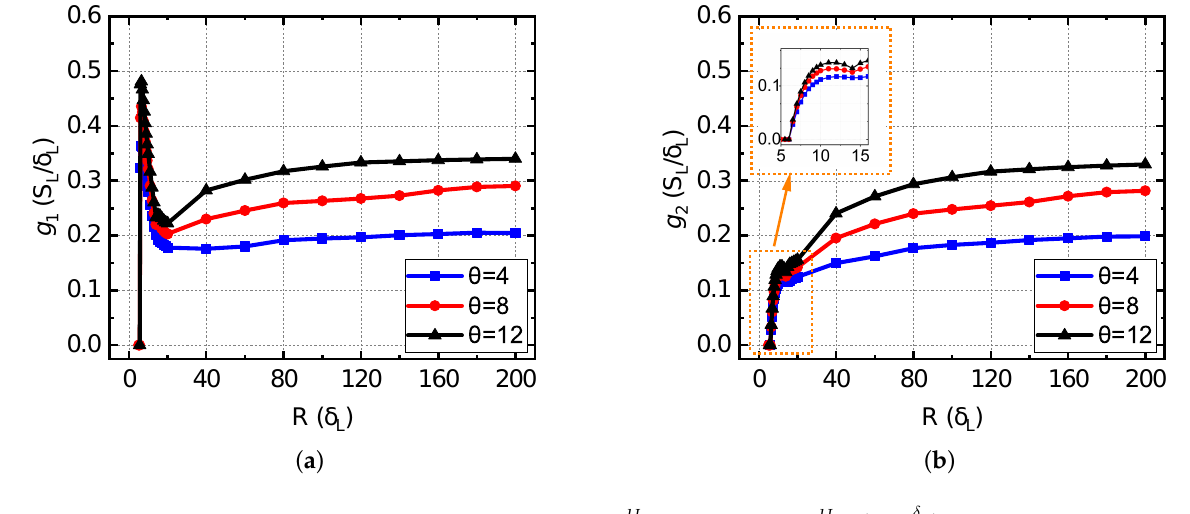
Figure 7. Dependence of g 1 = U max isothermal